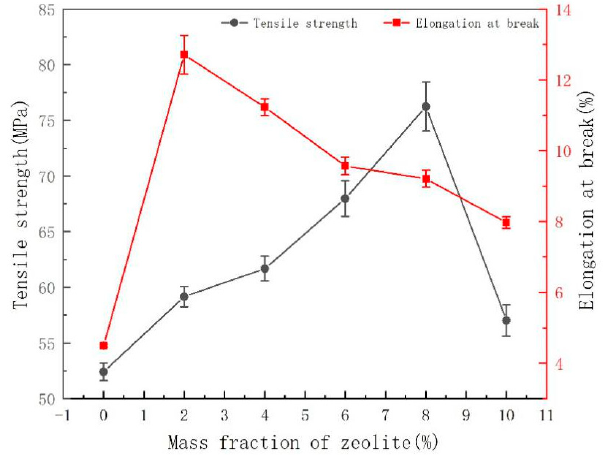
Figure 13. Effect of zeolite mass fraction on the mechanical properties of PLA composite films.